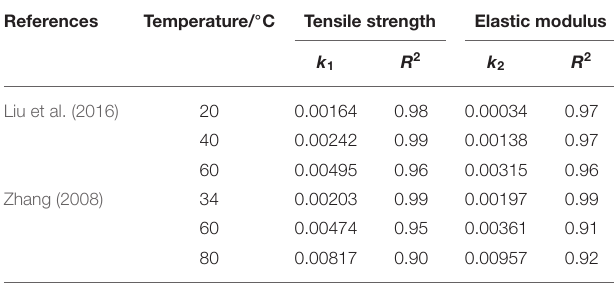
TABLE 2 | Coefficients of regression equations for GFRP tensile strength and elastic modulus